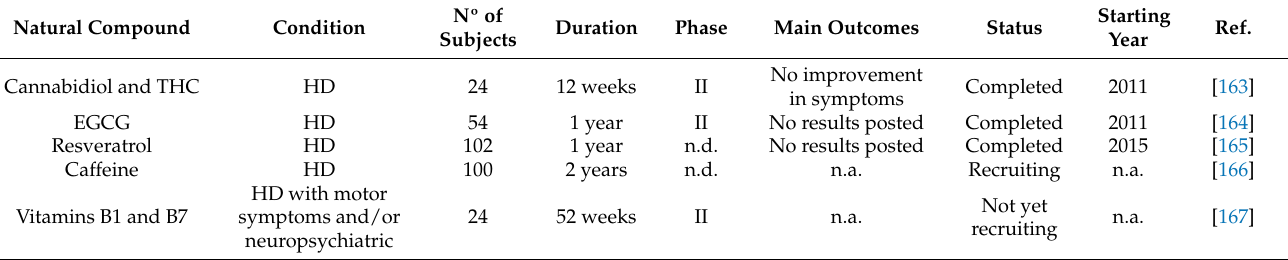
Table 5. Natural compounds in clinical trials for HD